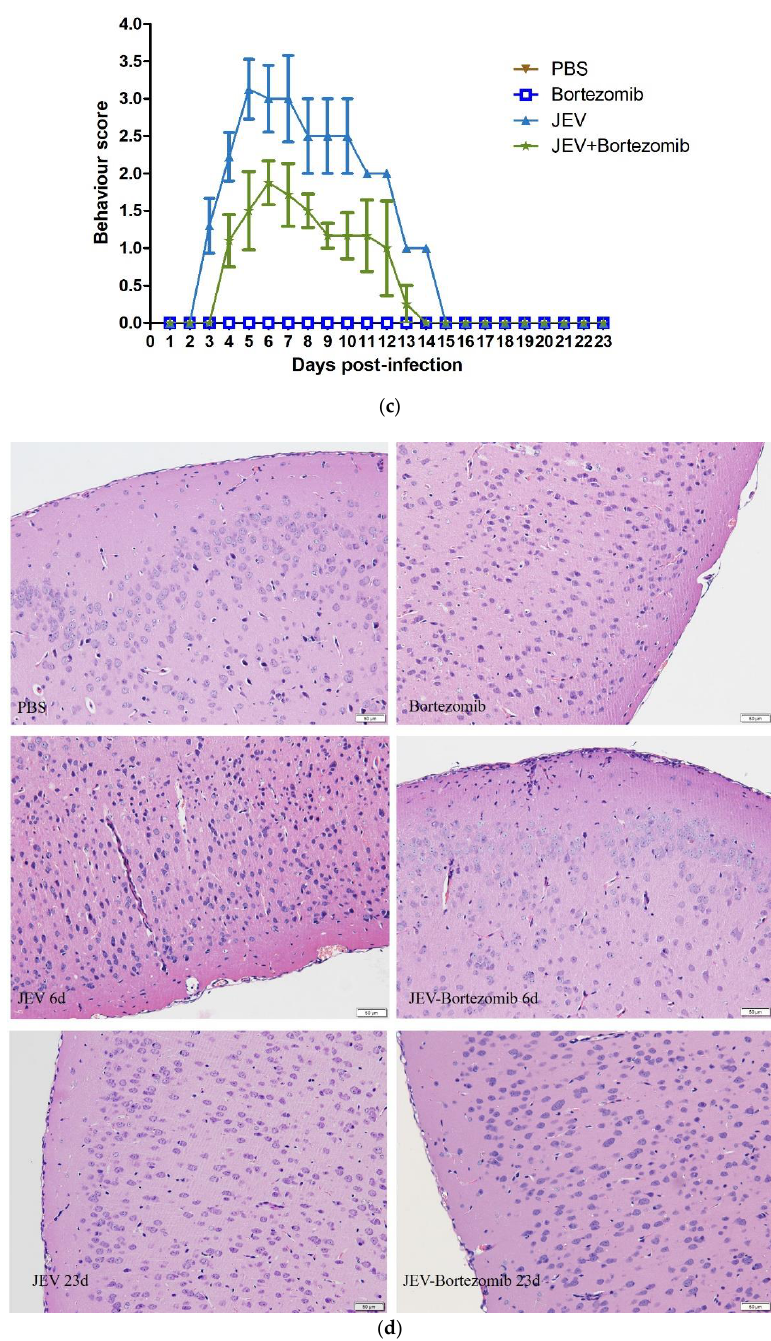
Figure 5. Therapeutic effects of bortezomib on JEV-infected mice. ( a ) Flow chart of animal studies. Mice infected with JEV were treated with PBS or bortezomib (0.5 mg/kg). Brain samples were analyzed on day 6 and day 23 of post-infection. ip: intraperitoneal injection. iv: intravenous injection. ( b ) Survival of mice in each group during the 23 days after JEV infection. Data are shown as Kaplan-Meier survival curves (n = 10 for each group). ( c ) Behavior score of mice in each group during 23 days after JEV infection. 0 = no restriction of movement; no blink frequently; no body stiffening; no hind limb paralysis. 1 = no restriction of movement; blink frequently; no body stiffening; no hind limb paralysis. 2 = restriction of movement; blink frequently; no body stiffening; no hind limb paralysis. 3 = restriction of movement; body stiffening; no hind limb paralysis. 4 = restriction of movement; eyes closed; body stiffening; hind limb paralysis, sometimes tremor. ( d ) Bortezomib reduces the damage in brains caused by JEV infection. Hematoxylin-eosin staining of brain coronal sections was performed to observe the pathological